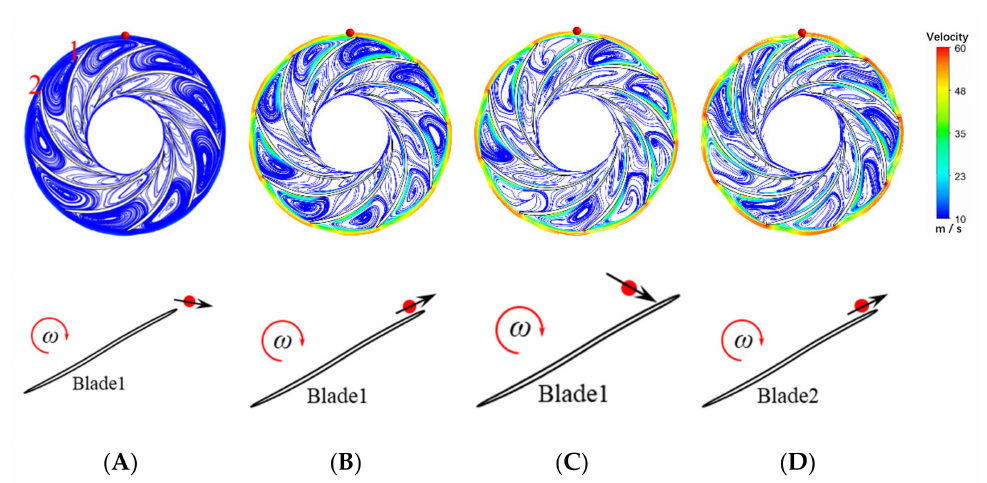
Figure 14. Evolution of flow patterns at runner inlet (0.5 SP); ( A ) t = 0.0 s; ( B ) t = 2.2 s; ( C ) t = 2.6 s; and ( D ) t = 3.2